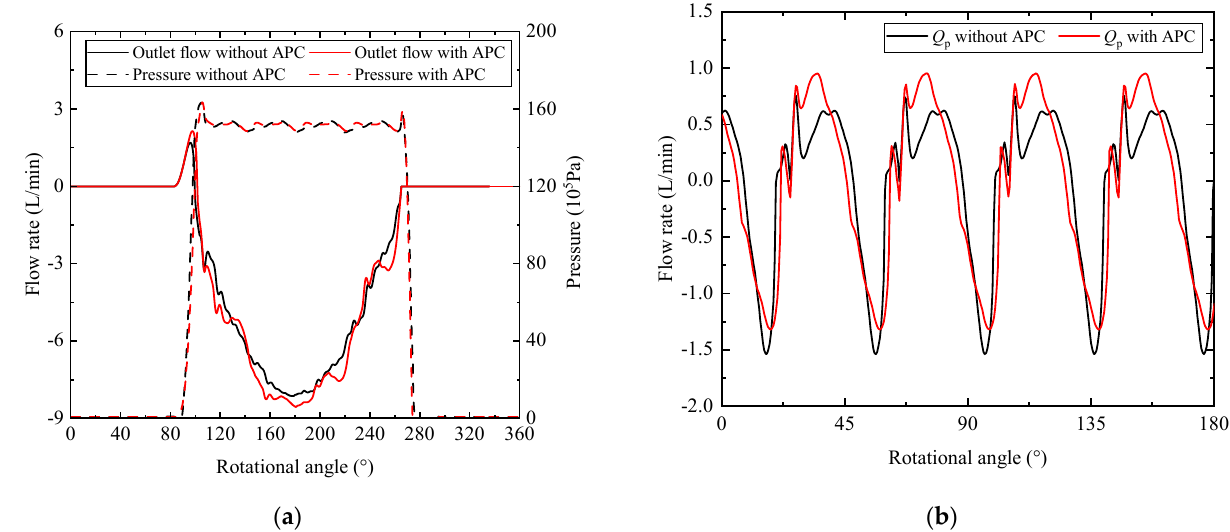
Figure 11. The effect on pumping pistons: ( a ) flow and pressure of a single piston; ( b ) sum of the flow.